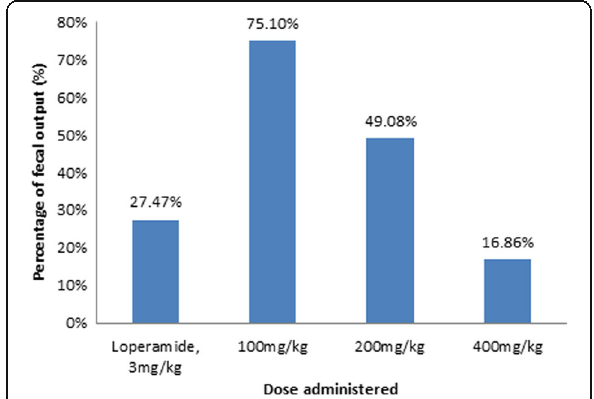
Fig. 1 Percentage mean fecal output of the aqueous stem extract of L. camara on castor oil induced diarrhea model in